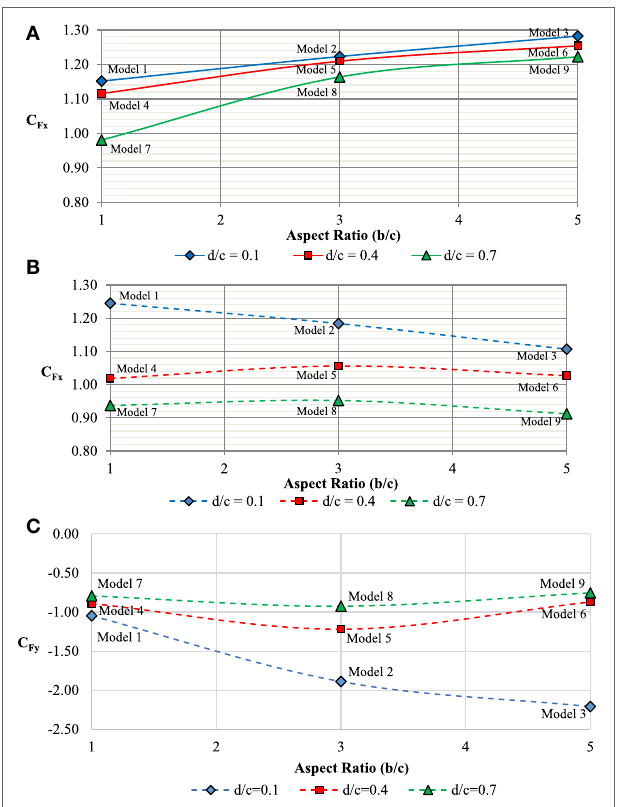
FIGURE 5 | Effect of aspect ratio on: (A) C Fx for 0°; (B) C Fx for 45°; (C) C Fy for 45°.